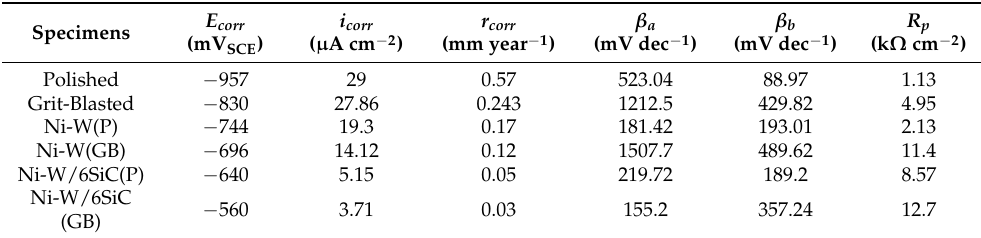
Figure 16. Polarization curves of the coatings prepared by scanning electrodeposition on 45 steel substrates with different pretreatment processes. Table 5. Electrochemical data from the potentiodynamic polarization curves of the polished, grit- blasted specimens and Ni-W/SiC coating on polished and grit-blasted 45 steels as a function of the SiC nanoparticle concentration in the electrolyte.